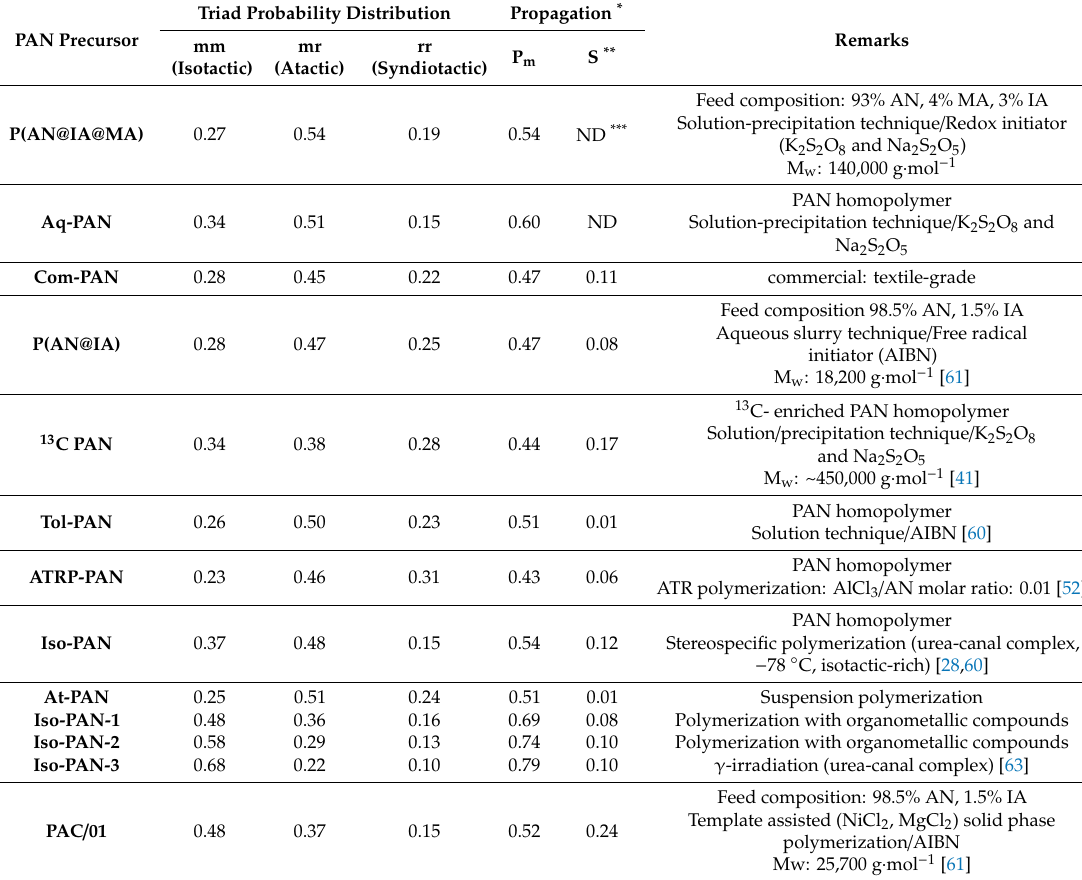
Table 1. Methine probability distribution of the triads for various polyacrylonitrile (PAN) polymers. Triad Probability Distribution Propagation PAN Precursor